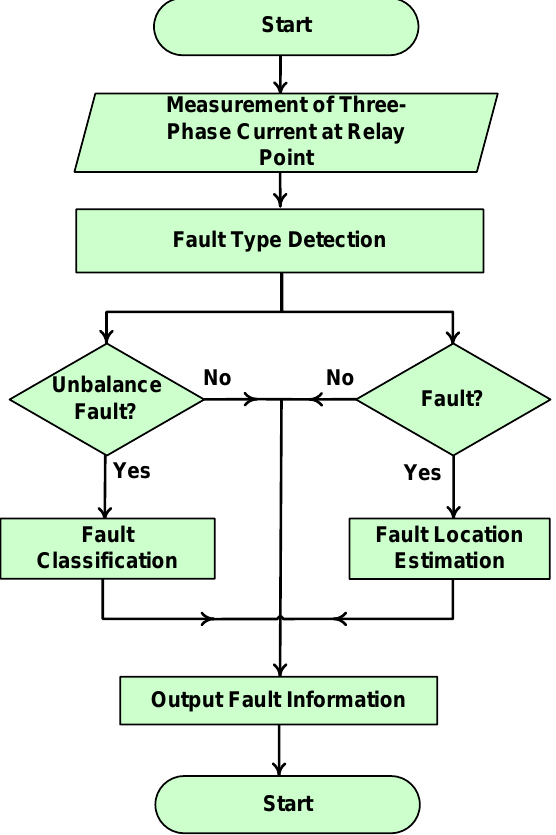
Figure 4. Flow chart of the proposed